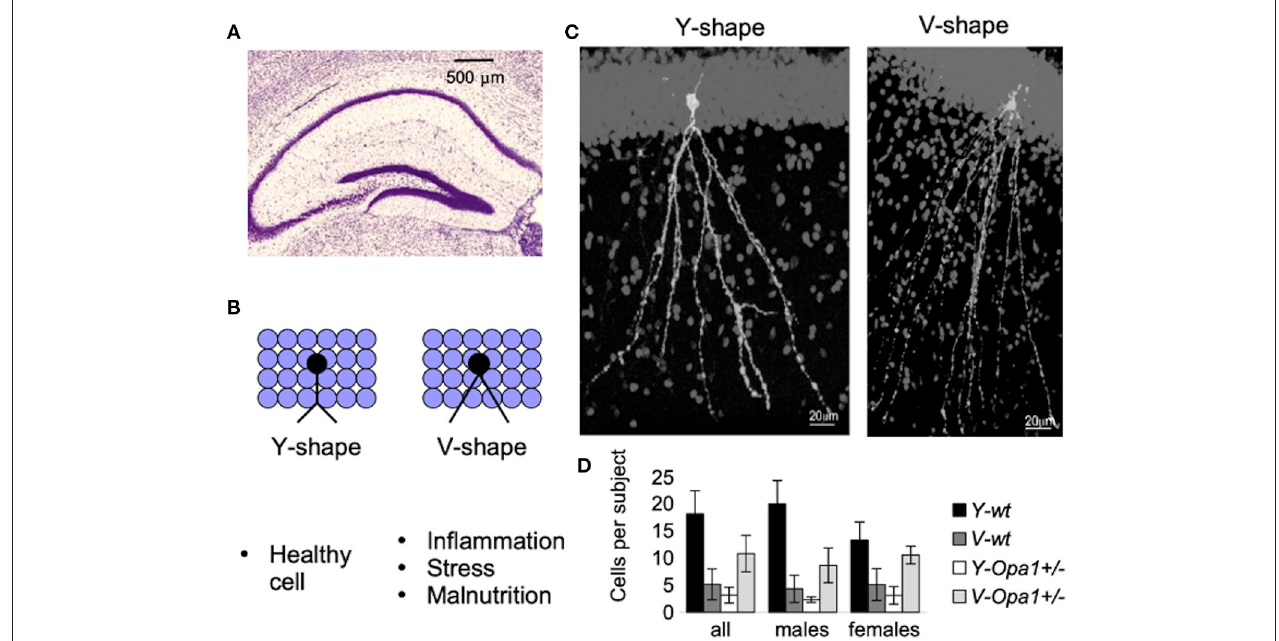
FIGURE 2 | New-born neurons are continuously being added to the hippocampal Dentate Gyrus (DG) throughout adulthood (A) . Detrimental factors (such as schizophrenia, stress, Alzheimer’s disease, seizures, stroke, inflammation, dietary deficiencies, or the consumption of drugs of abuse or toxic substances) and neuroprotective factors (physical exercise and environmental enrichment) influence maturation and morphology of new-born granular cells [reviewed in Llorens-Martín et al. ( 45)]. For example, there is a striking difference in the shape of the apical dendrites (B) . These morphological alterations may have important consequences (such as change in the pattern of synaptic connections, or change in the pattern of dendritic summation, and ultimately, change in cell excitability and functionality). An example of granular cells with different dendritic shafts are represented in (C) . Though both wt and Opa1 + /- animals had both types of granular cell morphology, in aged mice, the Y-type was attributed to 80% of all Diolistically labeled DG granular cells in wt [see Bevan et al. (44) for the details]. By contrast, in age-matched Opa1 + /- animals more cells were of V-type (D) . These changes are likely to be induced by a combination of stress factors in conjunction with impaired adult hippocampal